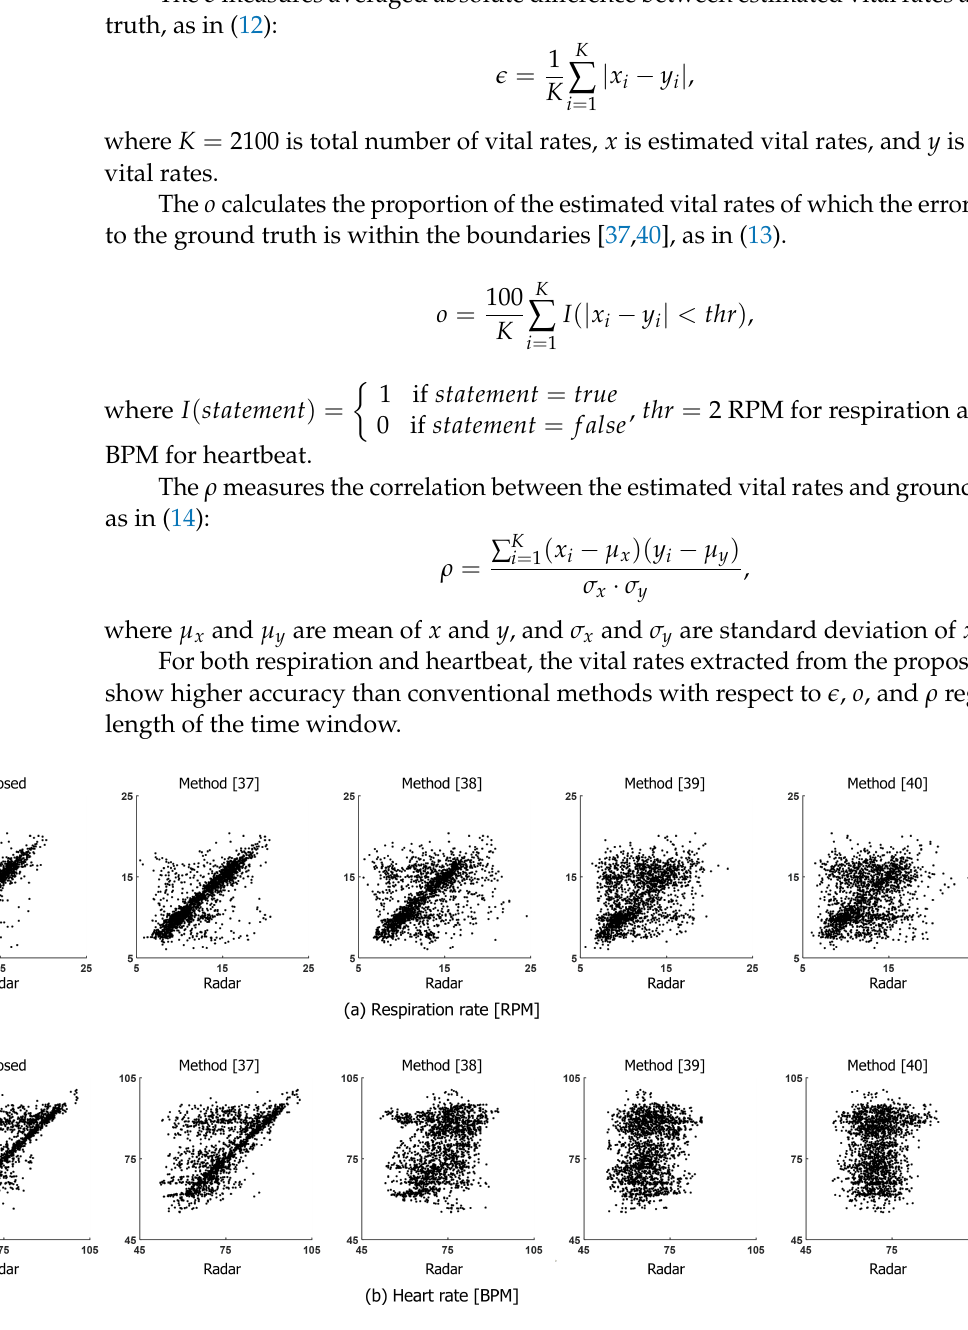
Figure 8. Comparison of radar based vital rates with reference. ( a ) Respiration rate, and ( b ) heart